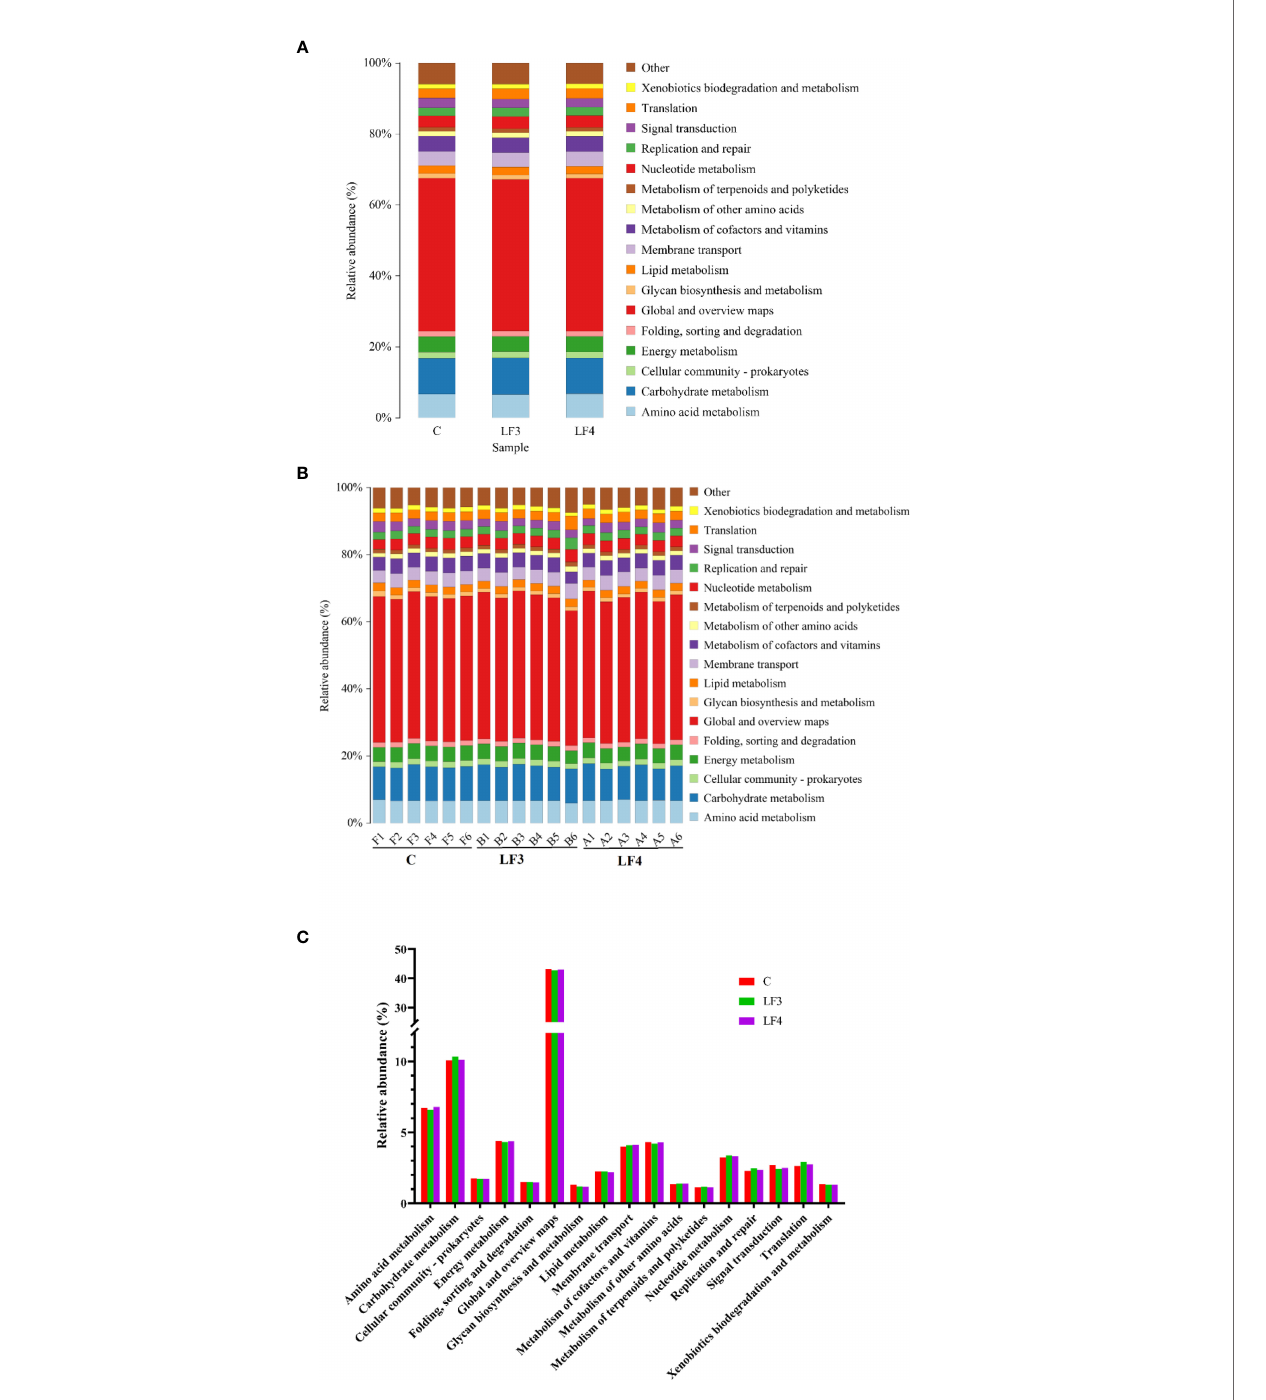
FIGURE 5 | Predicted functions of intestinal microbiota in groups C, LF3 and LF4. (A) mean abundances of three groups; (B) abundance of each sample; (C) level- 2 KEGG pathways with relative abundances over